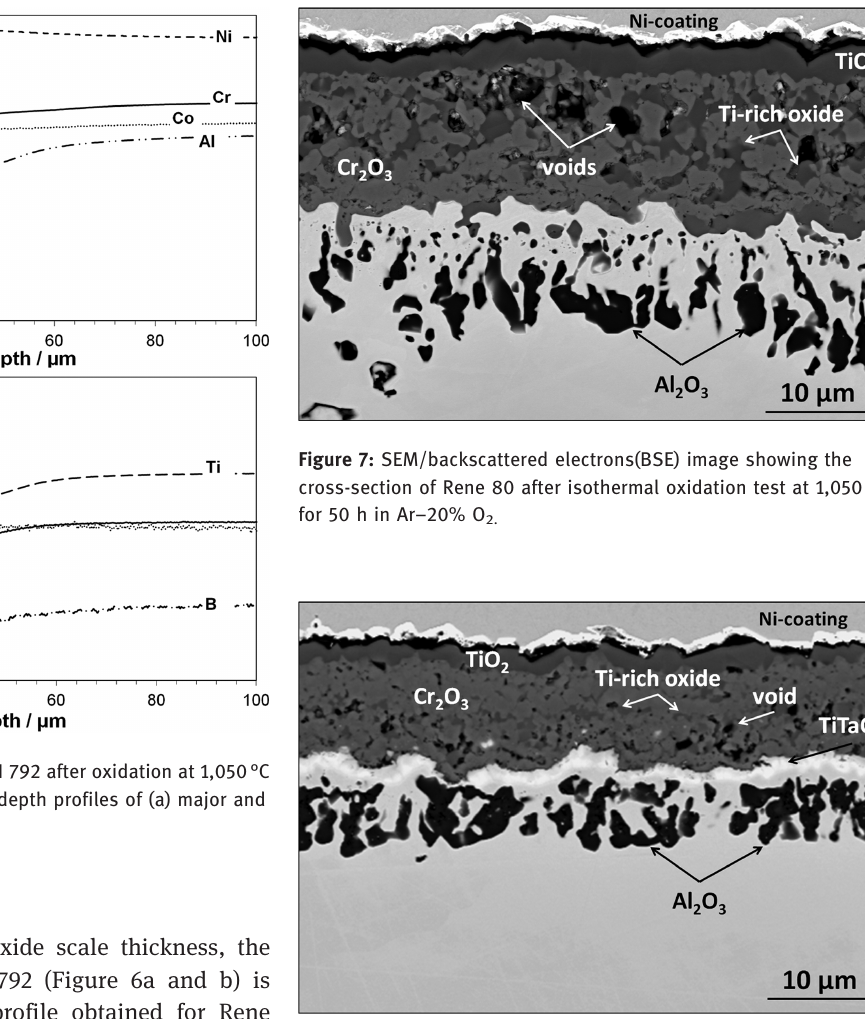
Figure 8: SEM/BSE image showing the cross-section of IN 792 after isothermal oxidation test at 1,050°C for 50 h in Ar – 20% O 2.